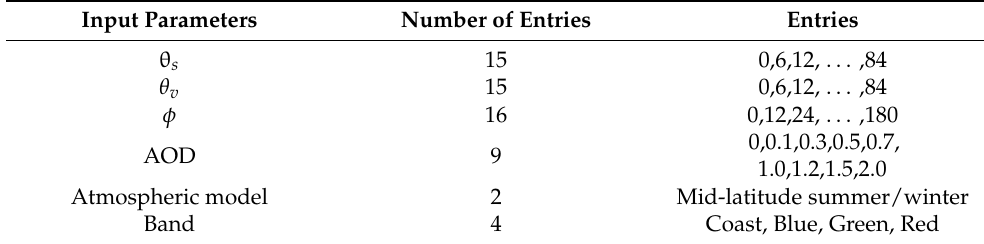
Table 4. The input parameters used to generate the lookup table.